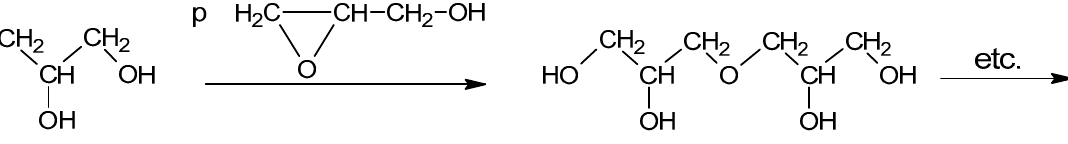
Description of abbreviations used in the table: GL—glycidol, OE—oxyethylene group from EC, H 2 O—water, K + —potassium ion from the catalyst K 2 CO 3 , Na + —sodium ion, CH 3 OH—methanol.